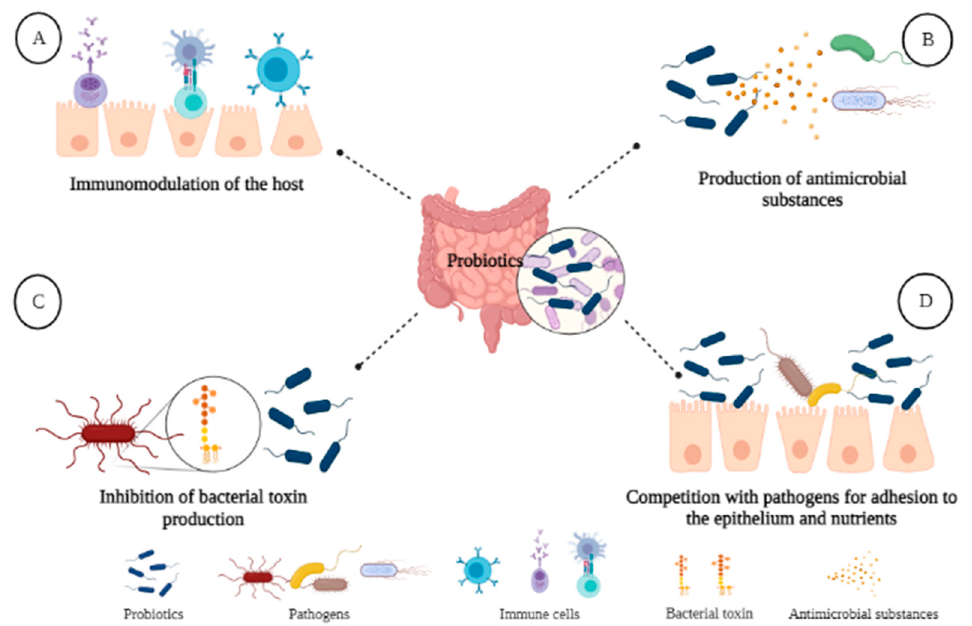
Figure 4. Action mechanisms of probiotics during gut colonization. ( A ) Human immunomodulation exerted by probiotics; ( B ) antagonism derived from production of antimicrobial substances; ( C ) in ‐ ( B ) antagonism derived from production of antimicrobial substances; ( C ) inhibition of toxin action by probiotic metabolism; hibition of toxin action by probiotic metabolism; ( D ) control of pathogen adhesion on epithelium by ( D ) control of pathogen adhesion on epithelium by a competition a competition mechanism.